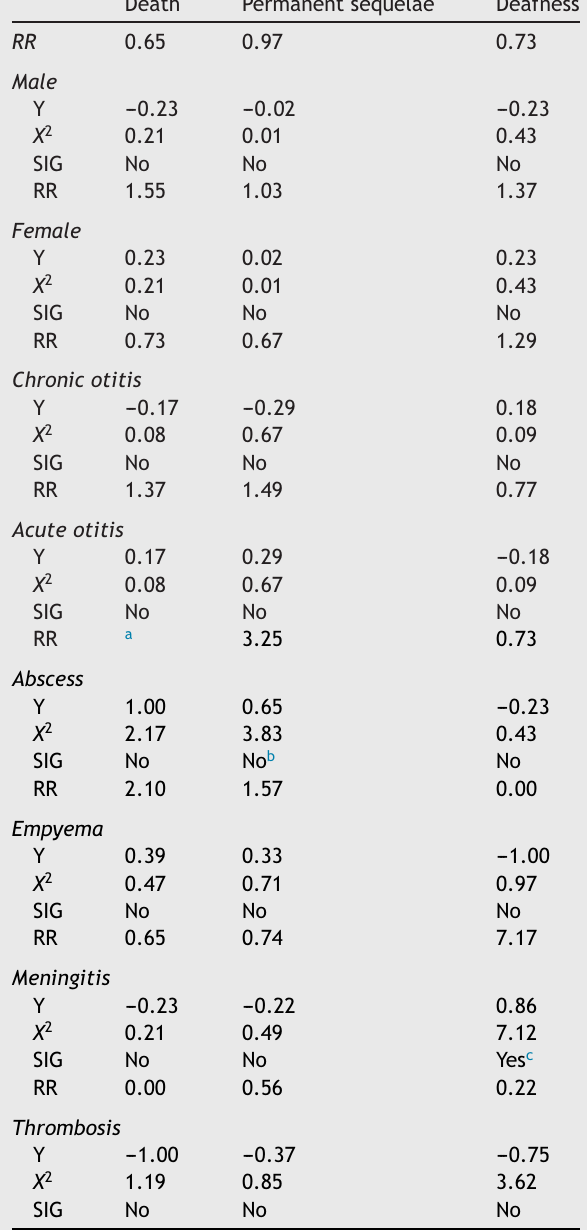
Statistical analysis of risk factors for death, per- manent sequelae and